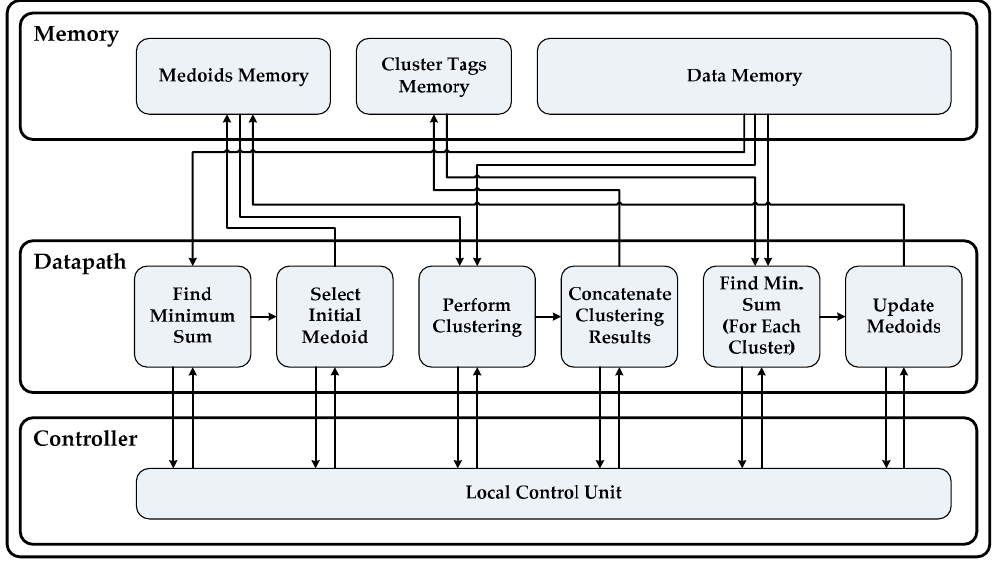
Figure 4. Internal structure of a processing element (PE).